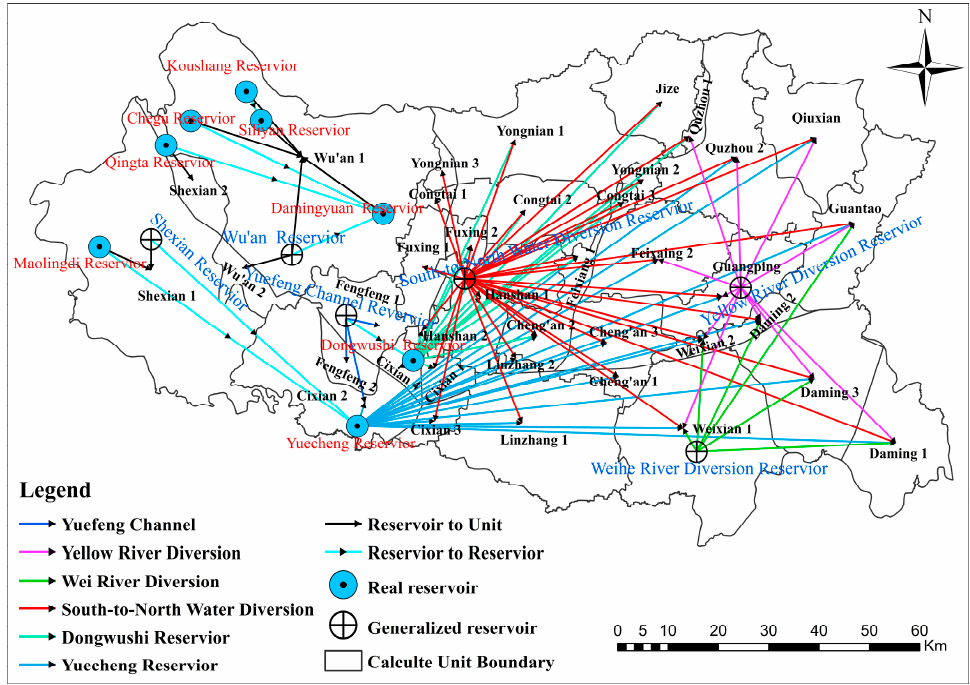
Figure 2. Topological diagram of water supply and consumption in the GWAS model.